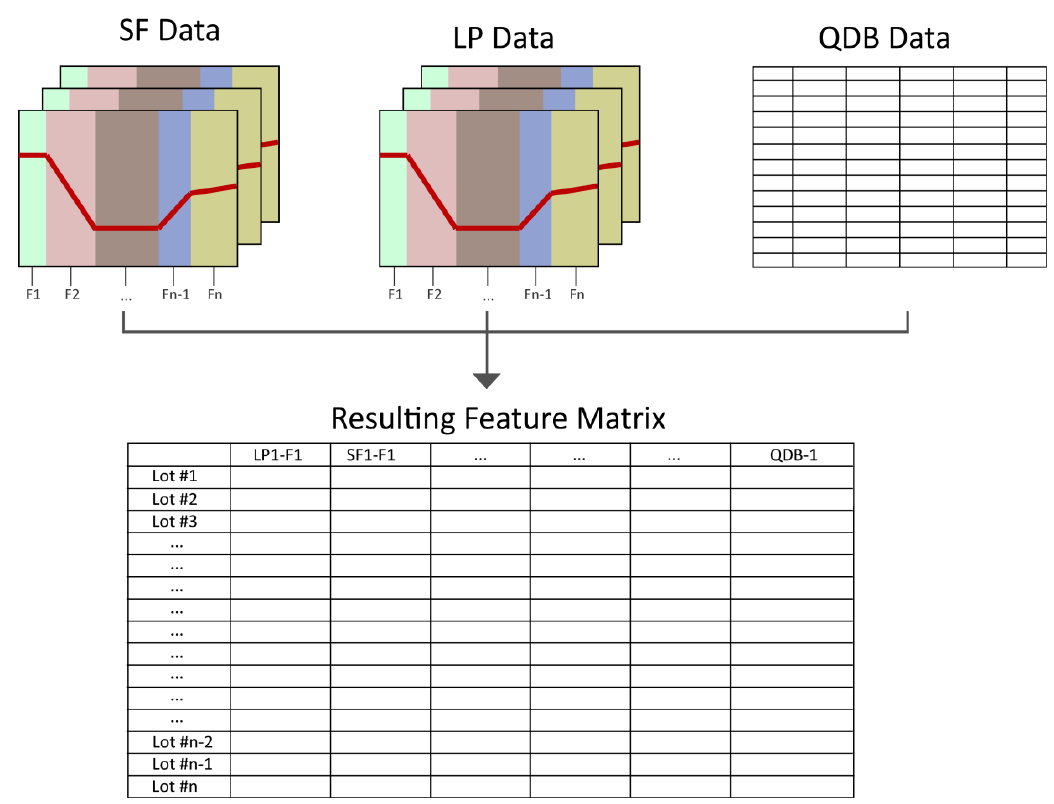
Figure 7. Schematic workflow of feature extraction. After the time-series data of SF and LP are separated into phases, various features are extracted (shown as F1, F2, …, Fn-1, Fn) from the data per lot and summarized in an overall feature matrix. Furthermore, the features of the QDB data are added to the feature matrix. The resulting feature matrix is ready for to be further processed by